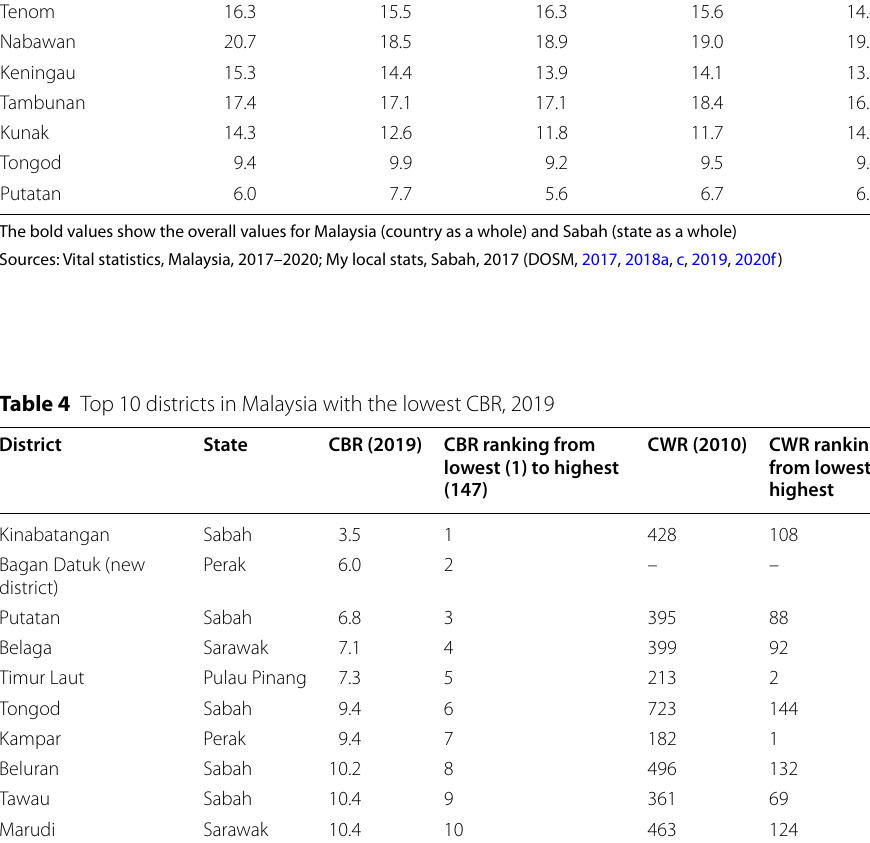
The CWR was computed using the 2% sample of the 2010 population